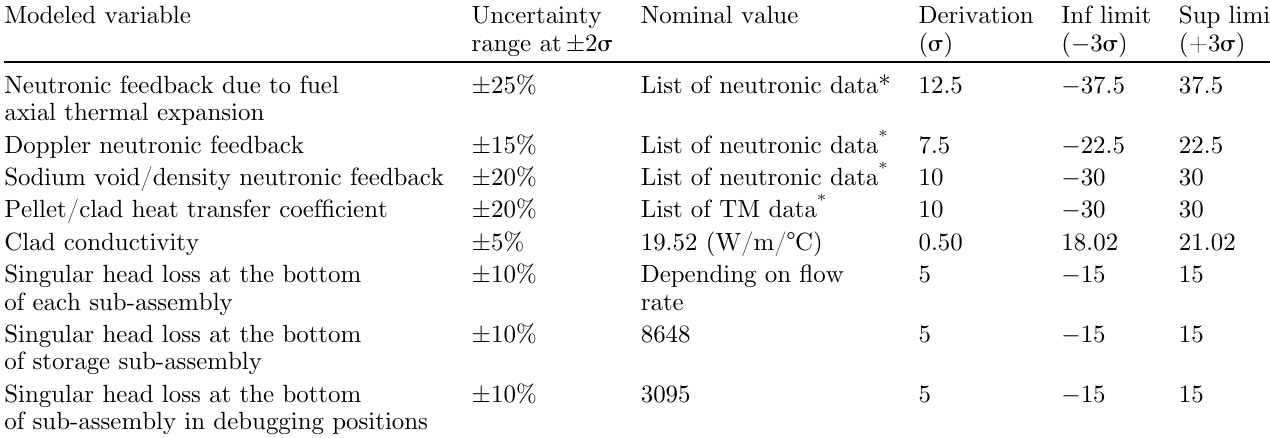
Table 6. Main model parameters uncertainties (1/2) (cid:1) truncated normal law at ±3 s (neutronic best estimate data issued from the ERANOS tool [37] and thermo mechanical (TM) data issued from GERMINALGERMINAL tool